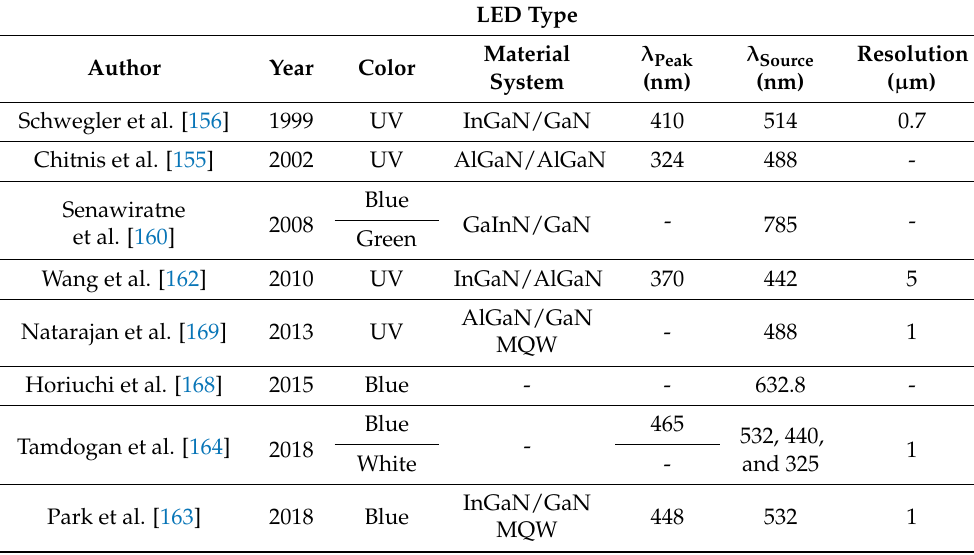
Table 3. Raman spectroscopy parameters that are employed in the literature for T j measurement of LEDs. References are sorted by year. Not reported parameters are indicated by a hyphen in the table. ( λ : wavelength).